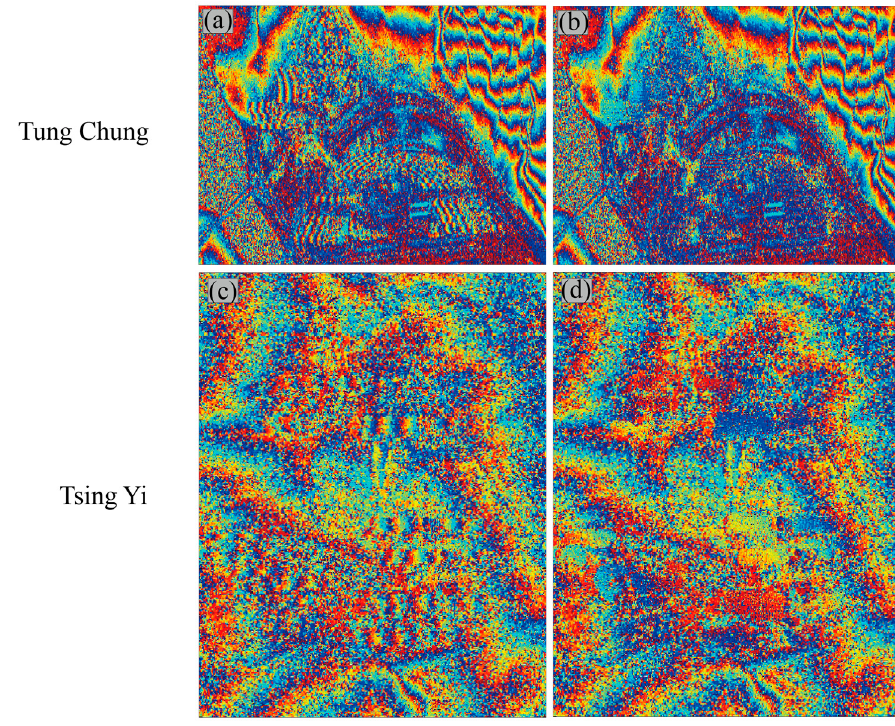
Figure 11. Result of building layover removal in real data: left ( a , c ) noisy interferogram; and right ( b , d ) removal result.